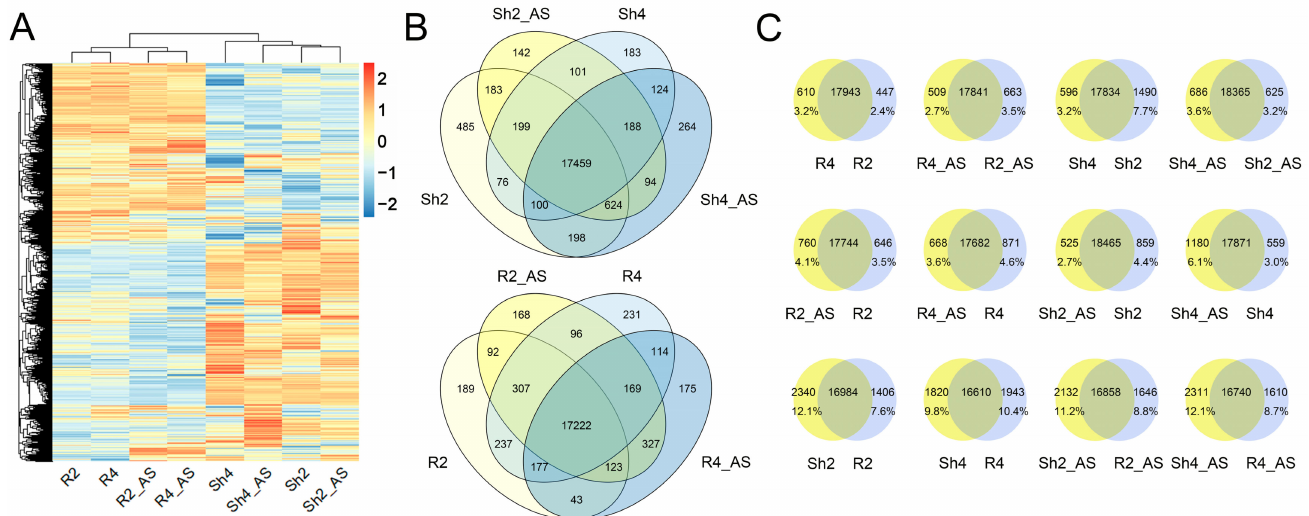
Figure 4. Genome-wide gene expression of roots and shoots between 9311-2x and 9311-4x rice plants under mock and high pH conditions. ( A ) Heatmap of gene expression levels in roots and shoots. R2 and R4 represent the root samples derived from 9311-2x and 9311-4x plants, respectively. R2_AS and R4_AS represent the alkaline stress treated root samples derived from 9311-2x and 9311-4x plants, respectively. Likewise, Sh2 and Sh4 represent the shoot samples derived from 9311-2x and 9311-4x plants, respectively. Sh2_AS and Sh4_AS represent the alkaline stress treated shoot samples derived from 9311-2x and 9311-4x plants, respectively. ( B ) Venn diagram of common and unique gene expression in roots and shoots. ( C ) Details of the gene expression between roots and shoots. Differentially expressed genes between roots and shoots. The number is marked on each